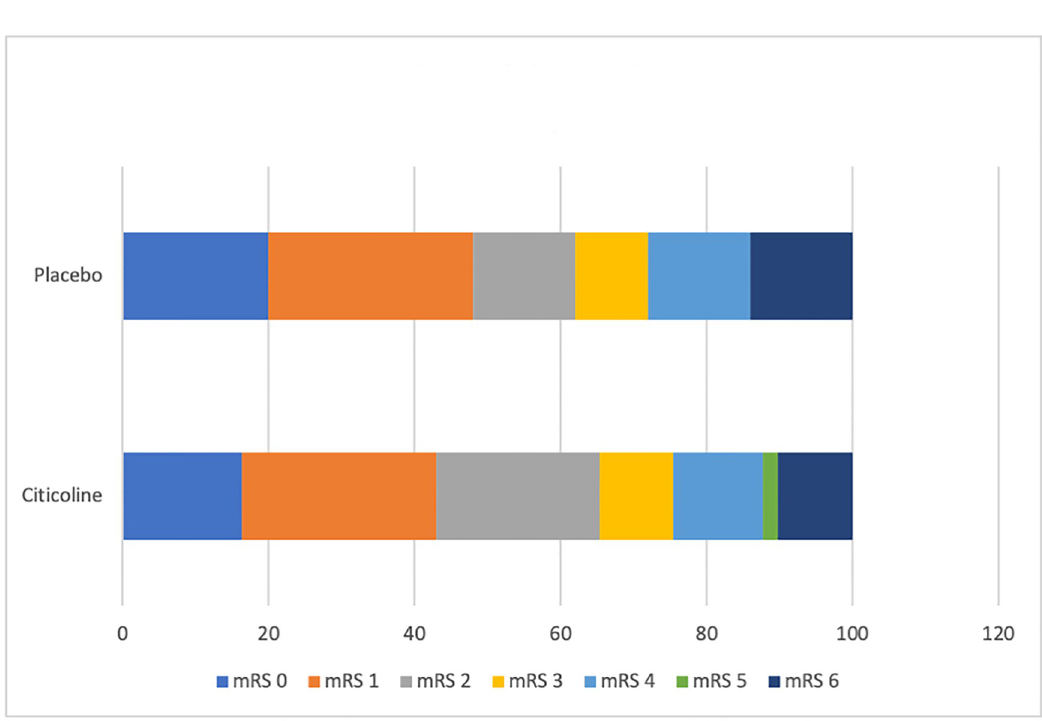
Fig 2. Shift analysis of the modified rankin scale (p value-0.700).